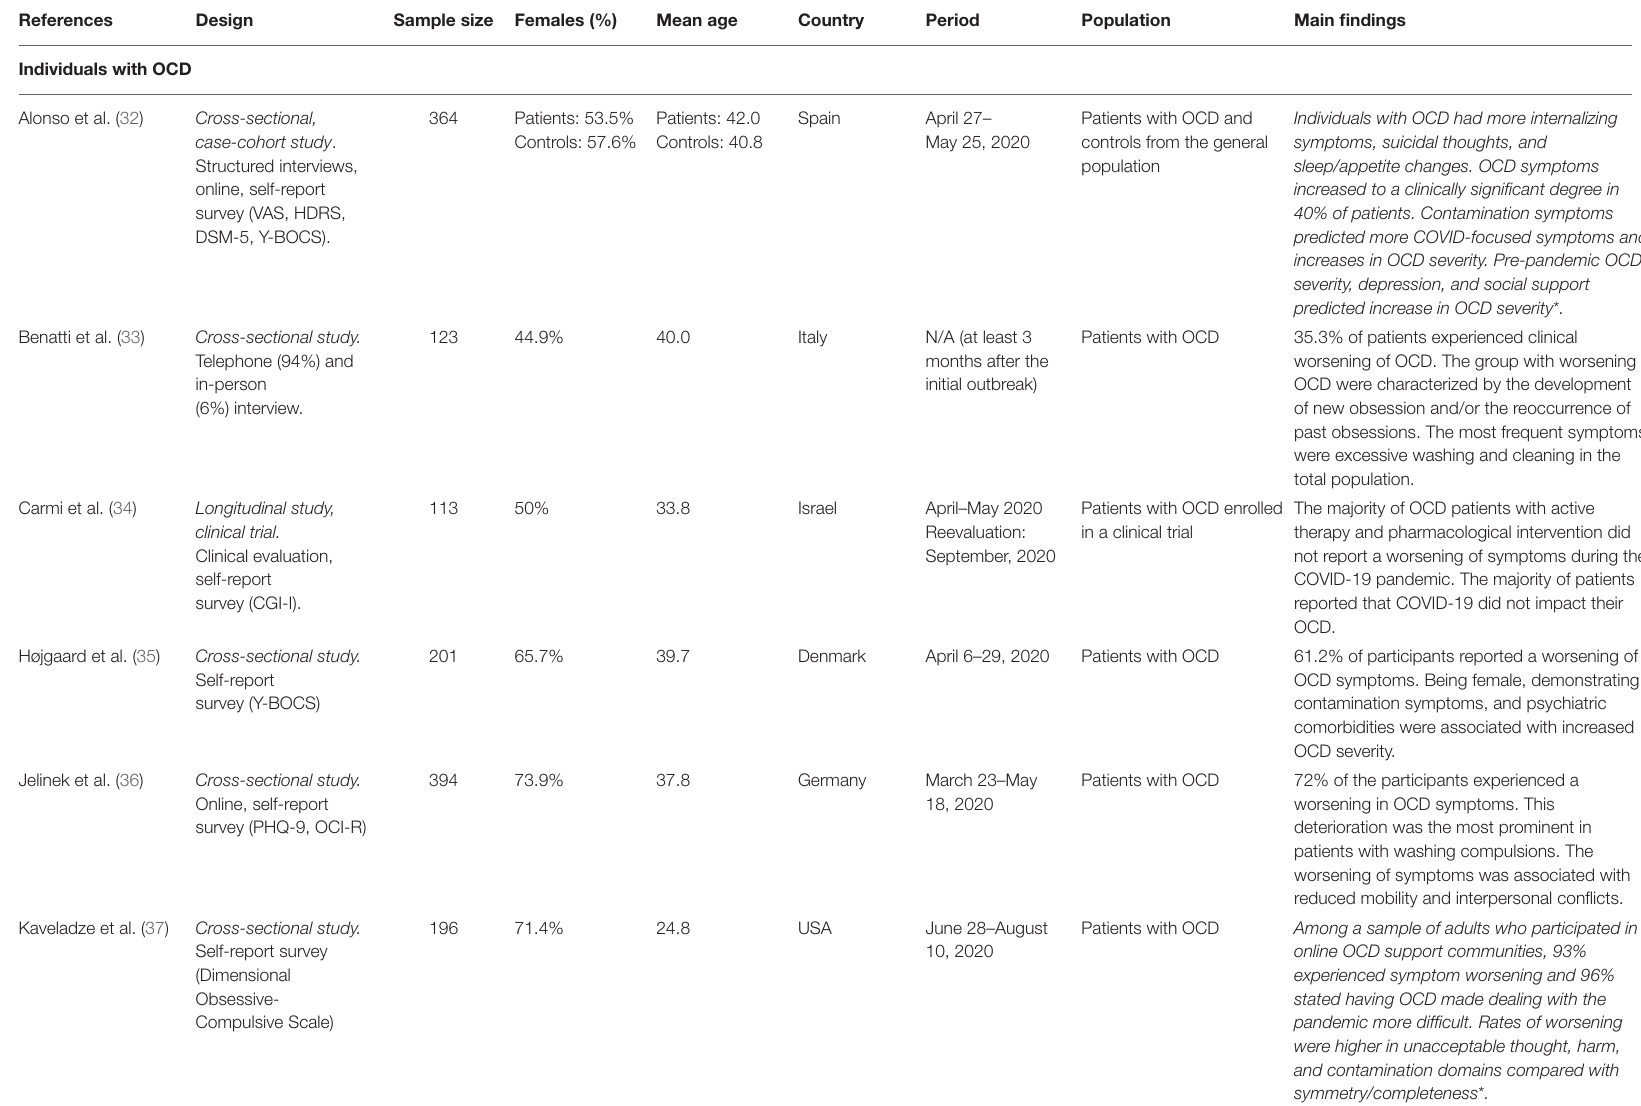
TABLE 1 | Original research articles related to the COVID-19 pandemic and